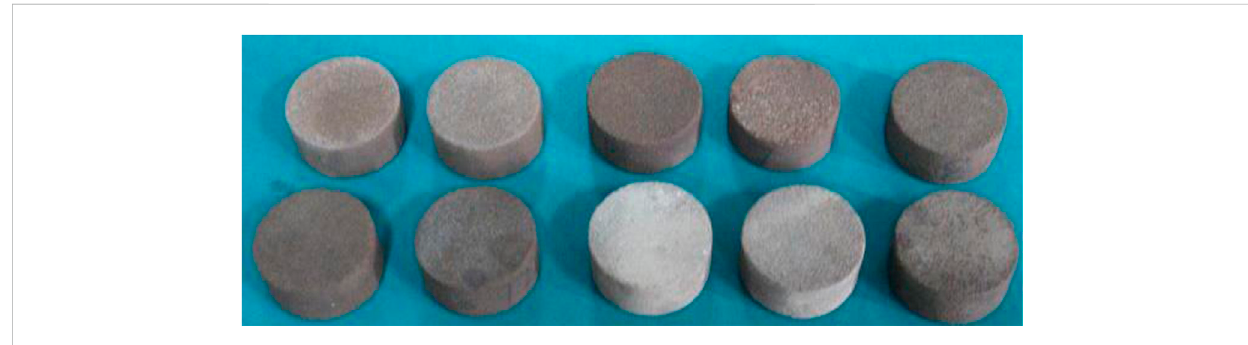
FIGURE 1 Brazilian disc